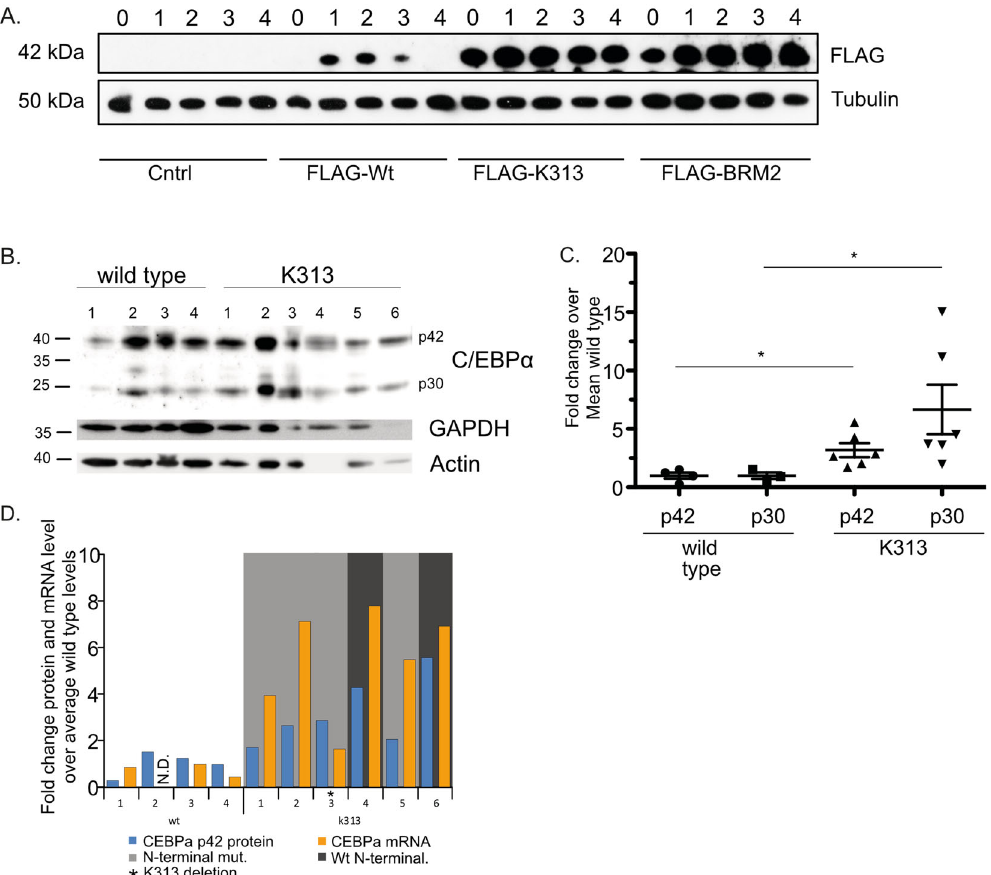
Fig. 4 C/EBP α -K313 and C/EBP α -BRM2 are expressed at higher levels than wild-type C/EBP α . A HoxB8 neutrophil progenitor cells expressing the indicated C/EBP α constructs were differentiated and samples were taken for western blot. Levels of C/EBP α were shown. B Primary human AML samples without (wild type) or with K313 mutations were analysed by western blot for C/EBP α levels. Both GAPDH and β -actin were used as loading controls. See table S1 for the speci fi c mutations. C Levels of C/EBP α isoforms were quanti fi ed for the indicated samples from B . and are shown as fold change over wild-type levels after normalising to loading controls. Mean is shown with error bars indicating standard error of mean. D Comparison of C/EBP α mRNA levels to protein levels in human AML samples from B . Indicated are whether or not N-terminal C/EBP α mutations are also